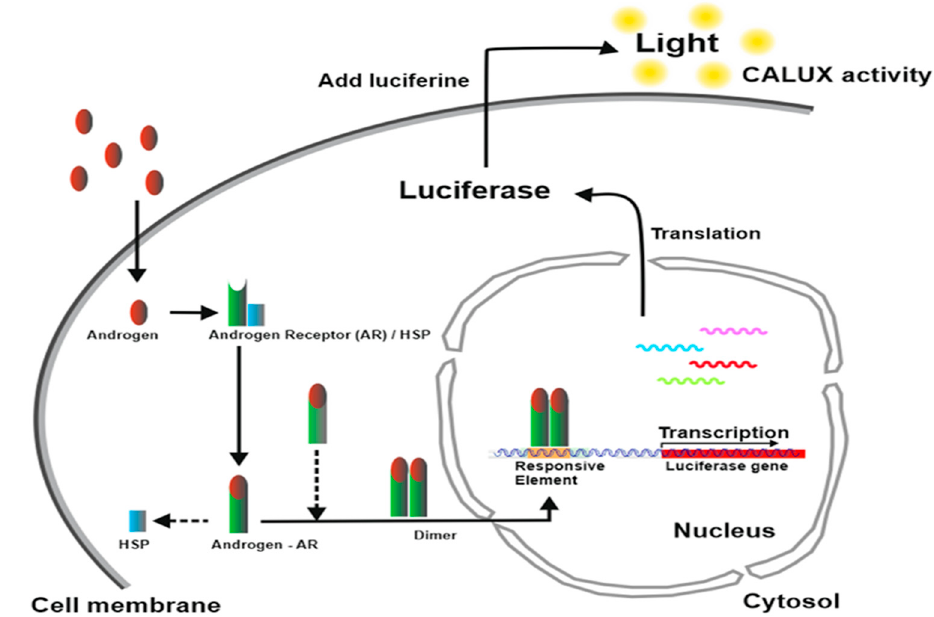
Figure 1. Diagram of the AR CALUX ® bio-analyses performed using human U2-OS cell lines stably transfected with an androgen-controlled luciferase reporter gene construct.